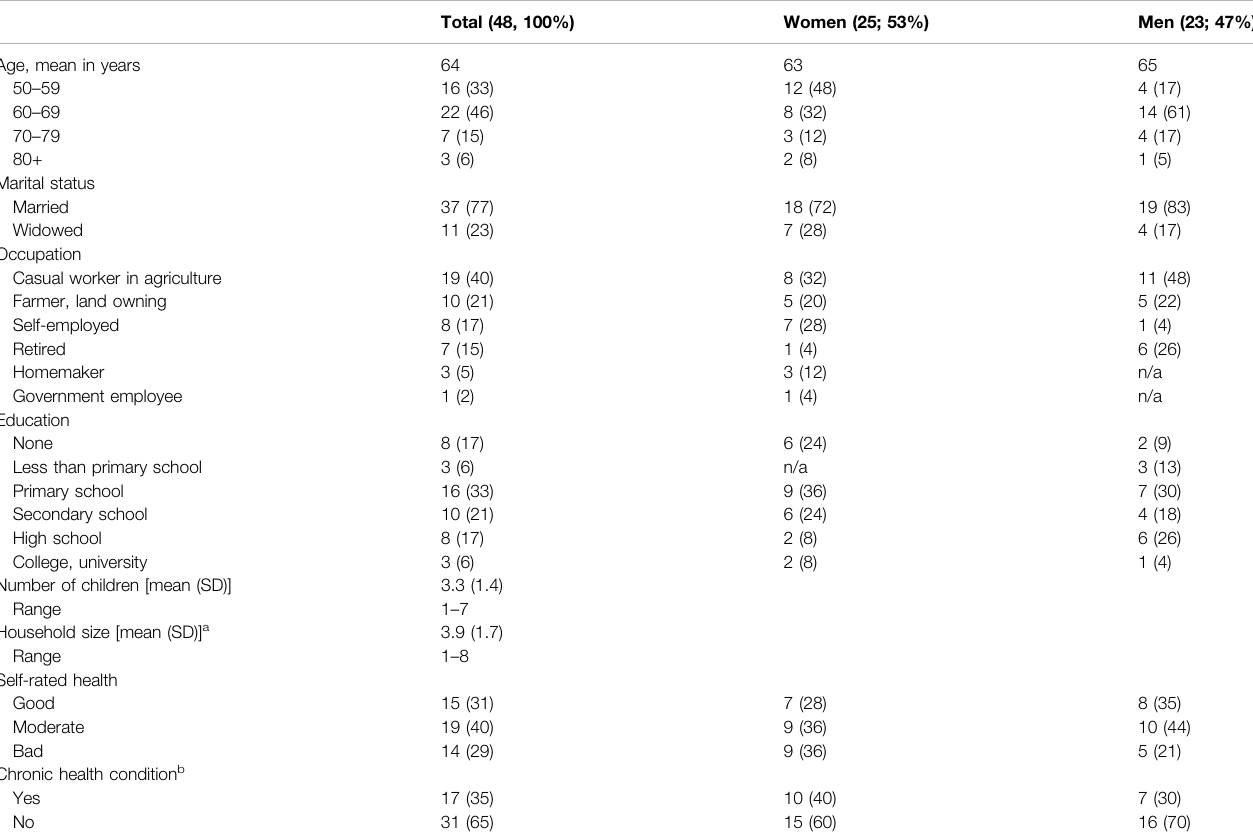
TABLE 2 | Respondents ’